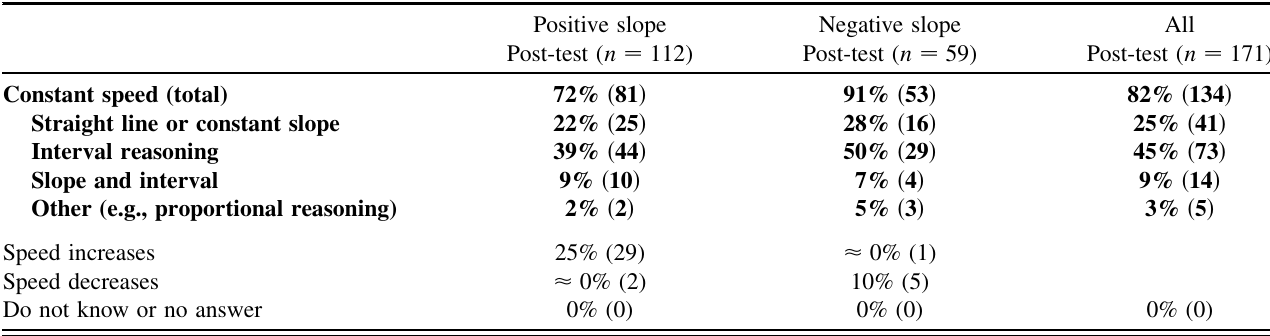
TABLE VII. Post-test results for the question whether the speed of the ball is increasing, decreasing, or constant.